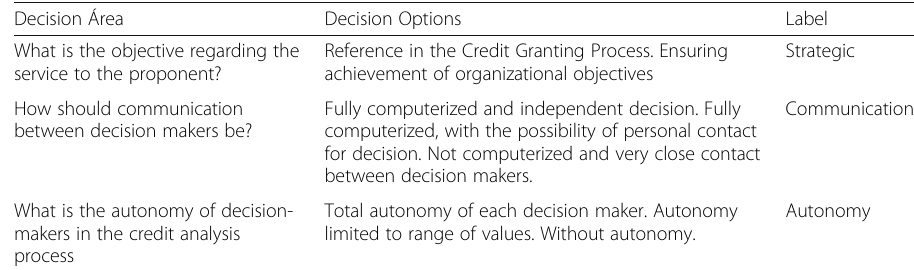
Table 2 Decision